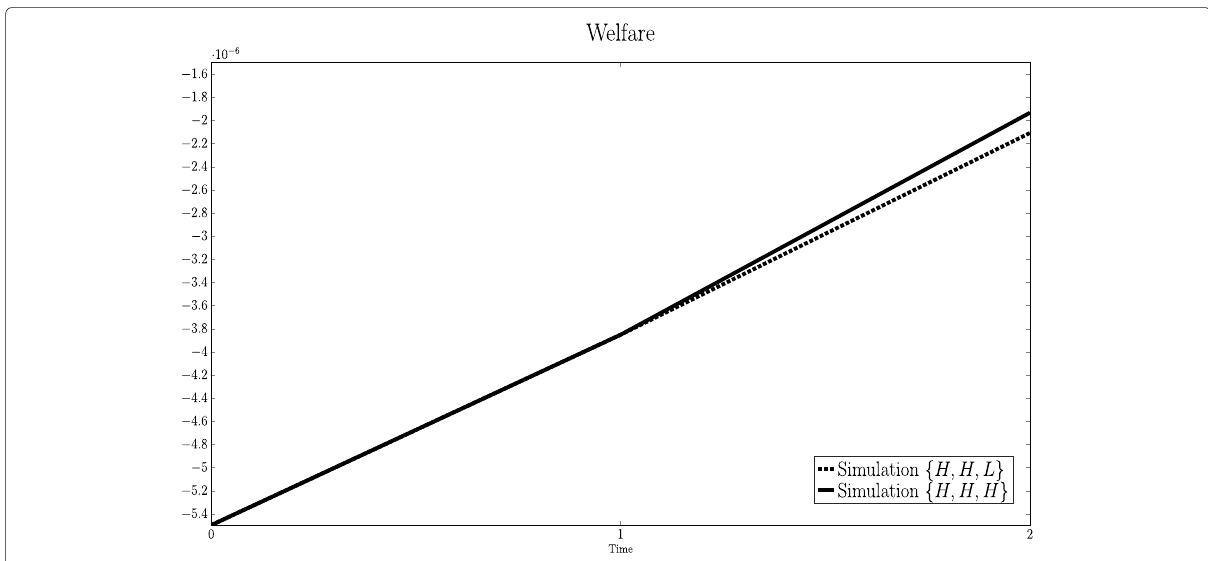
Fig. 5 Welfare under honored commitments. The dashed line presents the welfare under honored commitments if the cost-push sequence is { H , H , L } . The solid line presents the welfare under honored commitments if the cost-push sequence is { H , H , H }